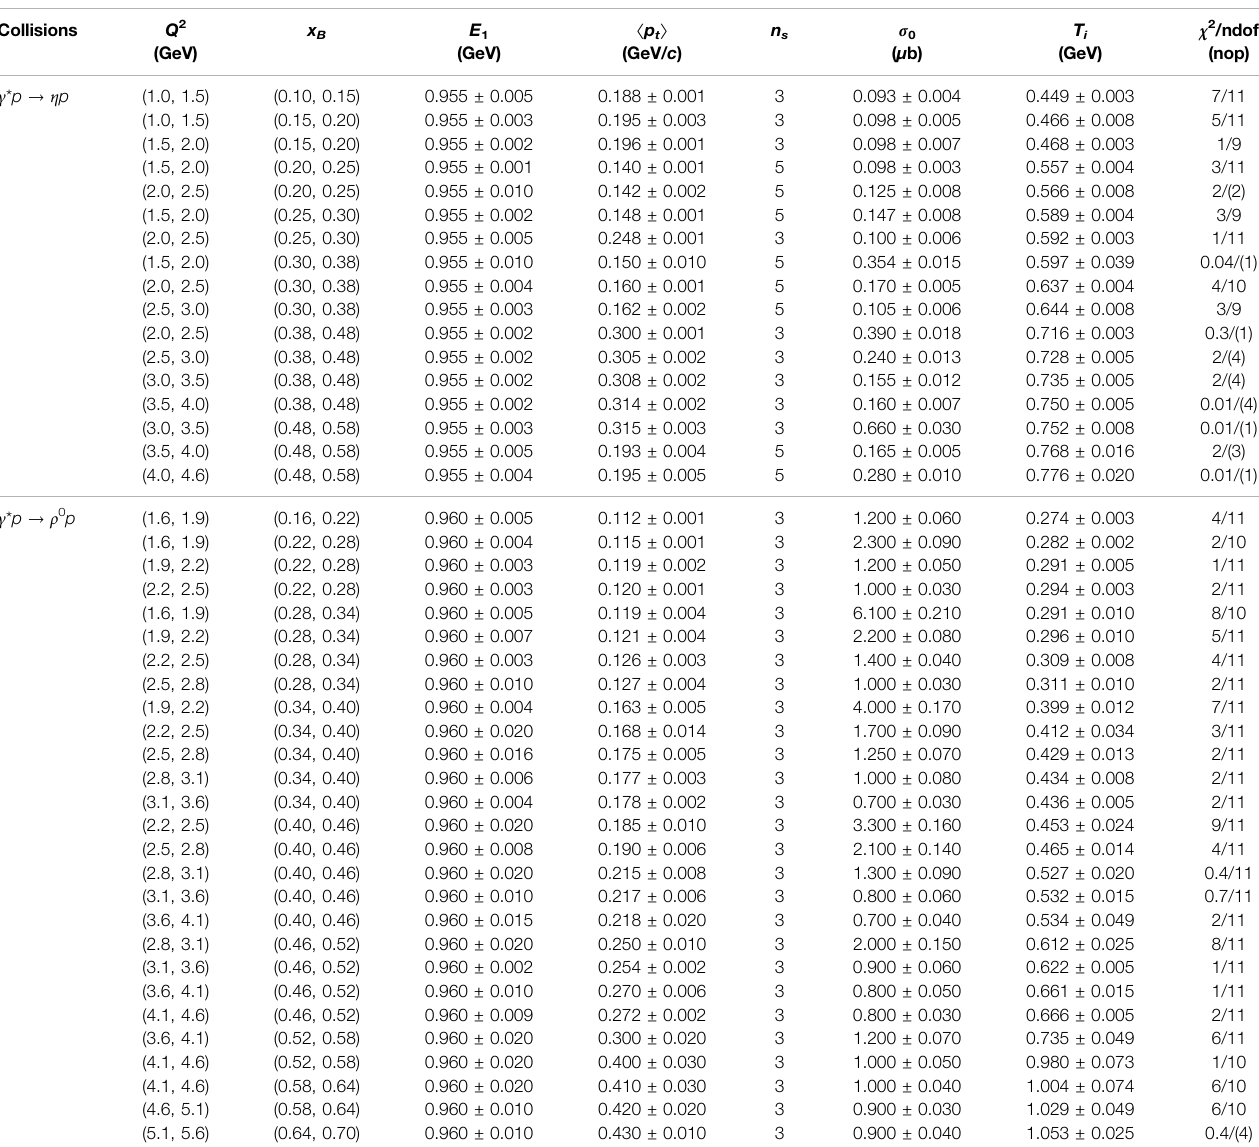
TABLE 2 | Same as Table 1 , but corresponding to the curves in Figure 3 , 4 .